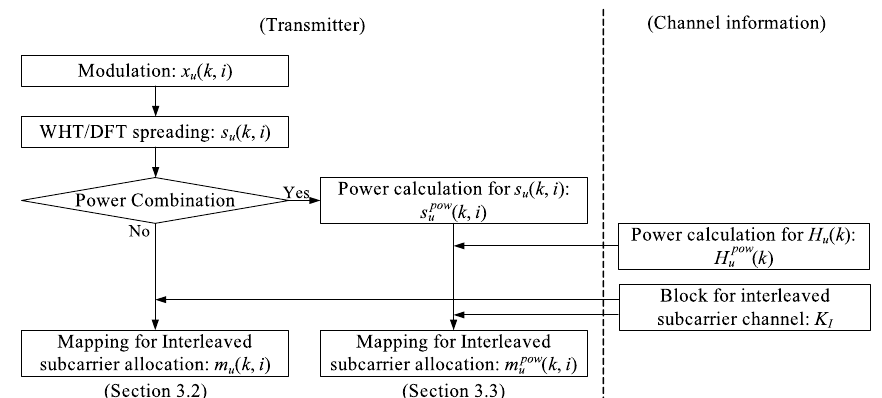
Fig. 3 Flowchart of the proposed interleaved block subcarrier allocation and power combination